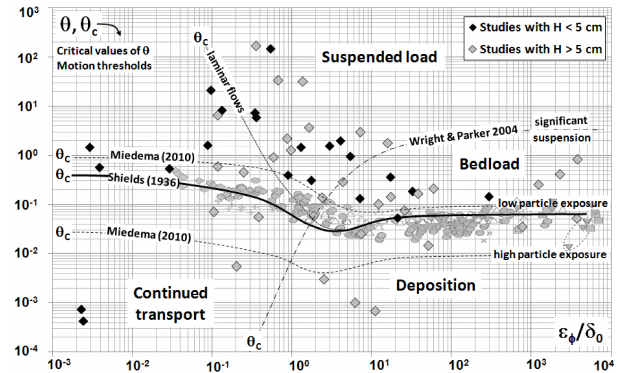
Figure 9. Generalized dimensionless Shields diagram that summa- rizes the conditions and regimes of sediment transport or deposi- tion, from the relative values of the Shields parameter ( θ ) and in- cipient motion criterion ( θ c ). The x axis bears the values of the ra- tio of particle size ( ε ϕ ) on the depth of the laminar sublayer ( δ 0 ). The diamonds refer to the studies cited in Appendix A that deal with morphodynamic issues: black diamonds for studies in which flow depth is H < 5cm, grey diamonds otherwise. Data in the back- ground show the critical θ c values reported in the wide Buffington and Montgomery (1997) review of incipient motion conditions for varied flow regimes, particle forms and